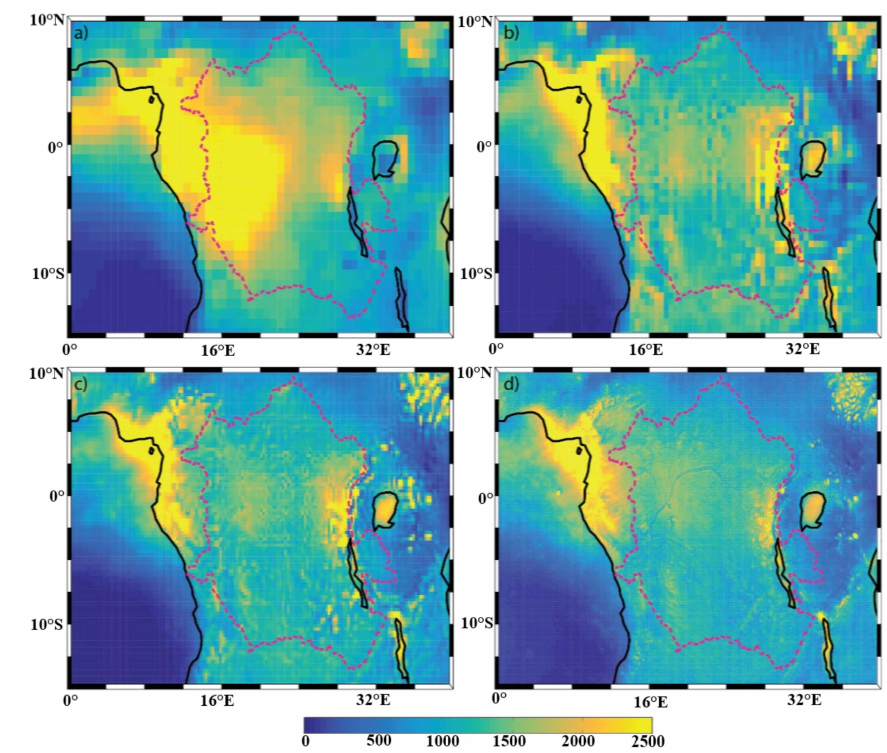
Figure 4. Spatial distribution of annual mean precipitation (mm/y) of the ( a ) ERA-I; ( b ) eERA5; ( c ) ERA5; and ( d ) ECOA datasets from 2016–2017. The Congo Basin is outlined with a dotted line.